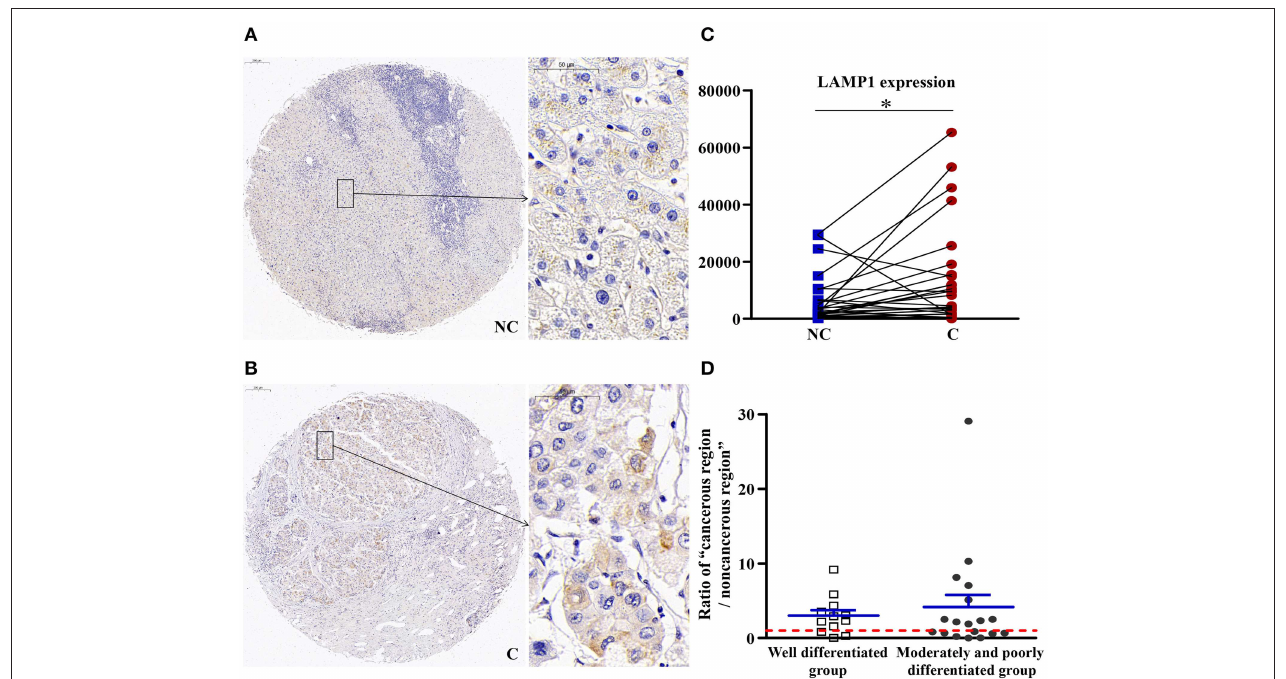
FIGURE 7 | The detailed expression LAMP1. Representative images of LAMP1 protein expression in liver cancer’s corresponding (A) non-cancerous (NC) and (B) cancerous (C) regions. (C) Quantification of LAMP1 expression level using multispectral image analysis in the liver cancer samples. (D) The ratio of “cancerous region/non-cancerous region” of LAMP1 expression in two groups (well-differentiated group vs. moderately and poorly differentiated group). The red line indicates that the ratio is equal to 1. Scale bar: 200 or 50 µ m. *Denotes significant differences from the noncancerous region with P <